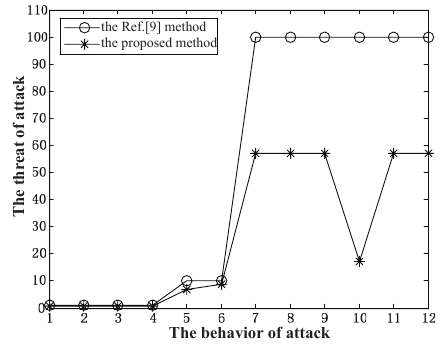
Figure 2: Comparison of the Threat of Attack with Two Methods